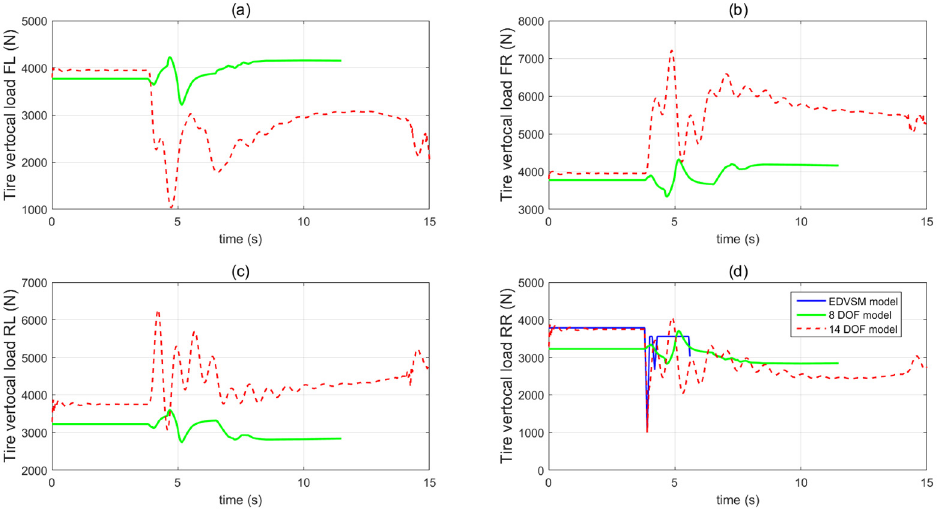
Figure 4. The vertical load responses of 8 DOF model and 14 DOF model ( a ) front left wheel ( b ) front right wheel ( c ) rear left wheel ( d ) rear right wheel. Table 1. Vehicle parameters of 8 DOF model and 14 DOF model (same as [7]).